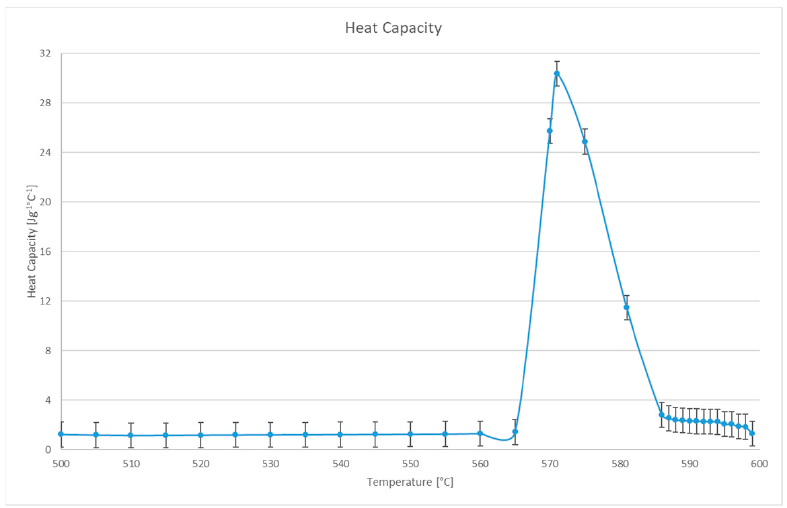
Figure 6. Averaged values of heat capacity with positive and negative deviations as a function of temperature.